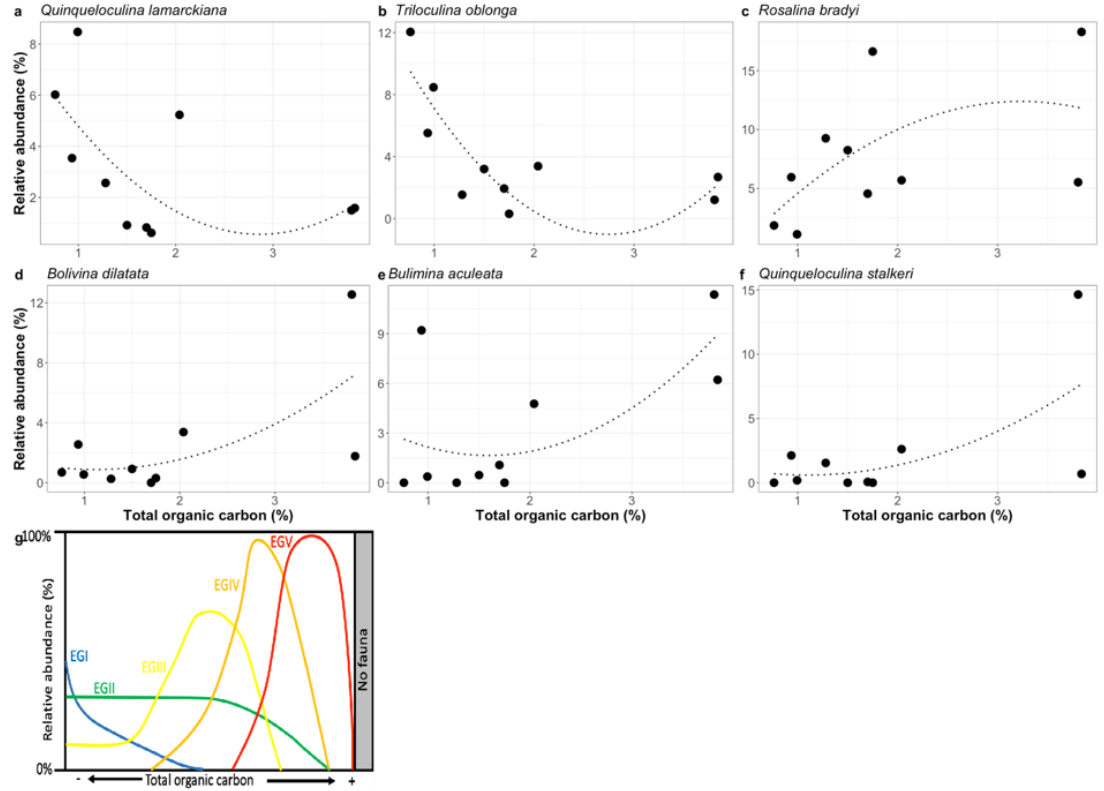
Figure 7. Distribution patterns of the relative abundances (filled black circles) against TOC at sampling sites (black dotted- line: second-order polynomial regression) of ( a ) Quinqueloculina lamarckiana , ( b ) Triloculina oblonga , ( c ) Rosalina bradyi , ( d ) Bolivina dilatata , ( e ) Bulimina aculeata , ( f ) Quinqueloculina stalkeri and ( g ) a theoretical model of the succession of species from the five EGs along the TOC gradient is shown in a panel (modified from [47]).